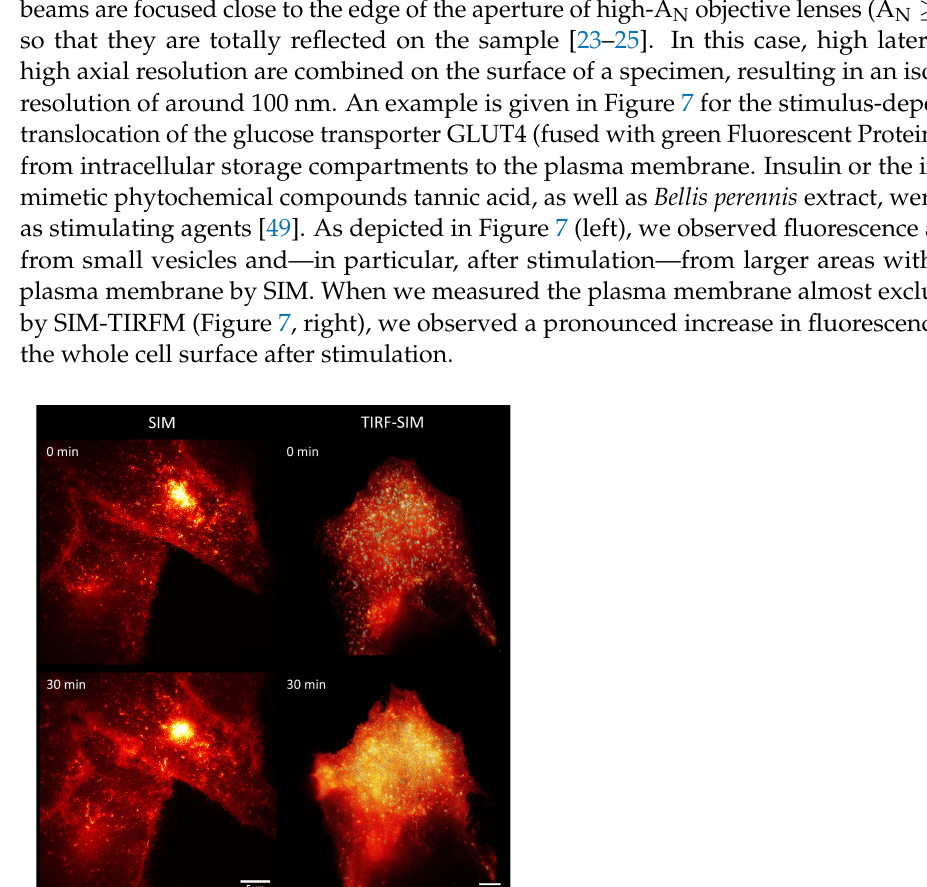
Figure 7. Comparison of SIM (left) and SIM-Total Internal Reflection Fluorescence Microscopy (TIRFM) (right): CHO-K1-hIR-myc-GLUT4-GFP cells prior to (0 min, upper parts) and subsequent to stimulation (30 min, lower parts) with Bellis perennis extract (common daisy; 10 mg/L); excitation wavelength: λ 0 = 488 nm; detection range: λ D 515 nm; Plan Neofluar 40 /1.30 oil immersion (left) or Plan Apochromat 63 /1.46 oil immersion objective lens (right). Reproduced from Ref. [49] with modifications.